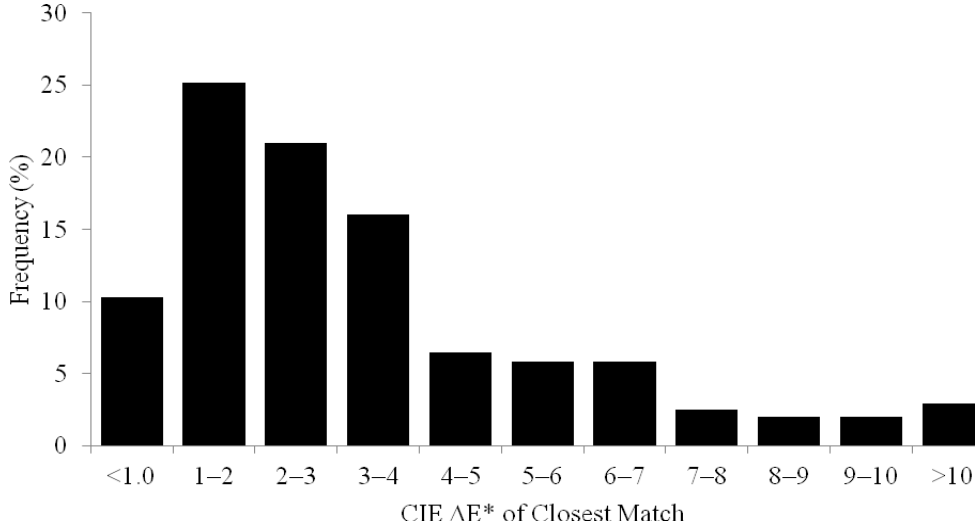
Figure 3. Frequency distribution of the minimum  E* using the master Chromascop shade guide for the pooled sample of teeth (n=335). The mean of  E*,  Ecov, is